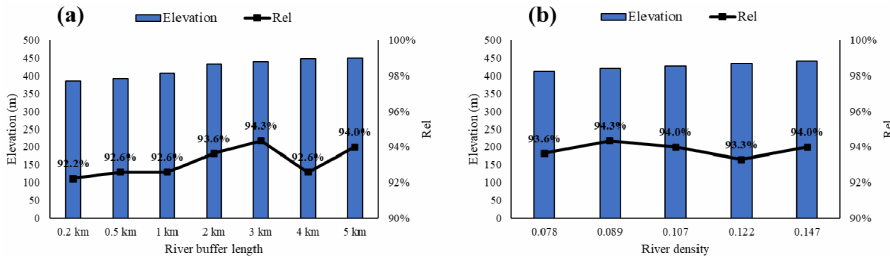
Figure 14. The reliability of ( a ) different river buffer lengths, and ( b ) different river densities. In addition to the length of the river buffer zone, the density of the river network (total river length/area) will also affect the final confluence result. Therefore, five river networks with different densities were generated using the hydrological analysis toolbox in ArcGIS 10.2: 0.078, 0.089 (the same river network used in Section 4), 0.107, 0.122, and 0.147. According to the results presented above, a 3 km buffer length was adopted. The results are shown in Figure